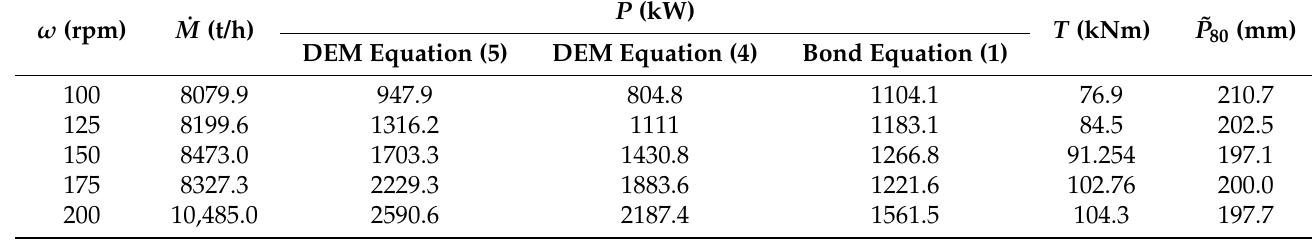
Table 7. Simulation results at different eccentric speed and oss = 240 mm and crushing power calculated with Bond’s equation.